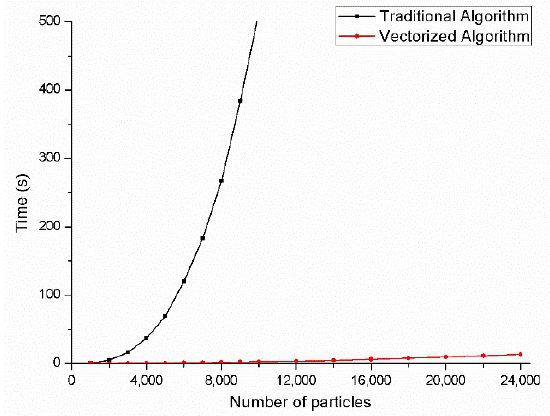
Figure 7. The calculation time comparison between the traditional algorithm and the vectorized algorithm as the number of macro particles.